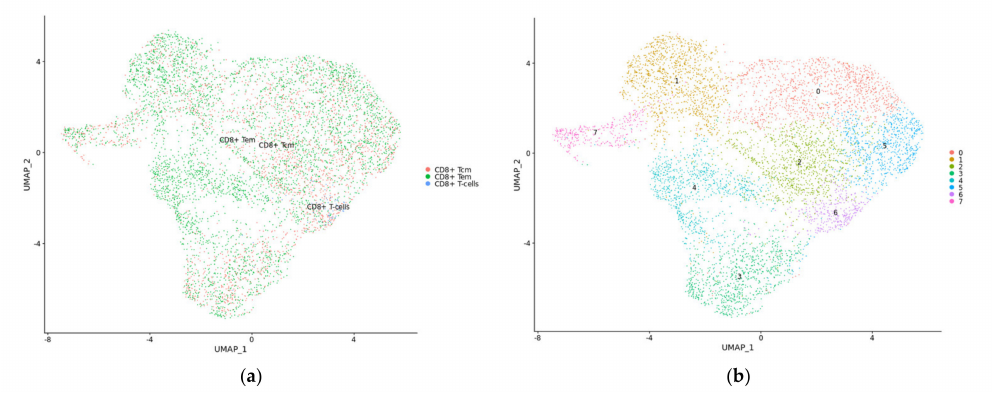
Figure 9. Sub-clusters of CD8T cells from CRC scRNAseq analysis. ( a ) CD8+ T central memory (CM, red), CD8+T effector memory (EM, green), and CD8+ T cell (blue) clusters identified by SingleR subtype identifier. ( b ) Eight distinct CD8+ T cell sub-clusters generated with reclustered CD8+ T CM , CD8+ T EM , and CD8+ T cells; each colored dot indicates a distinct cluster. The x -axis and y -axis are two dimensions of the